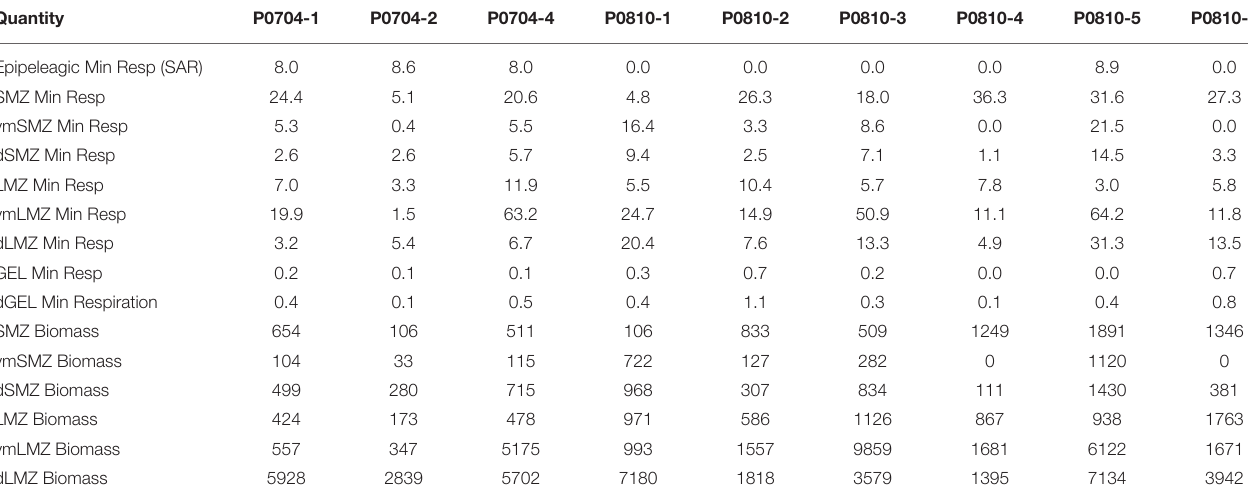
TABLE A2 | Mesozooplankton biomass and minimum respiration estimates used in the